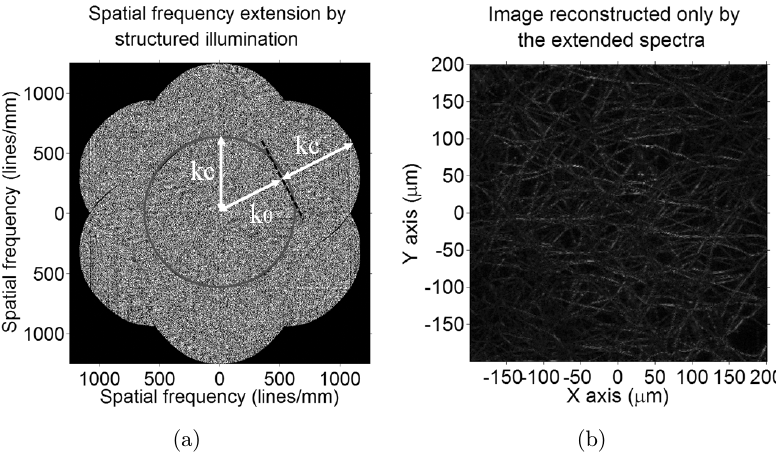
Fig. 5. Spectrum extension (a) and image reconstruction and (b) in two directions by structured illumination.